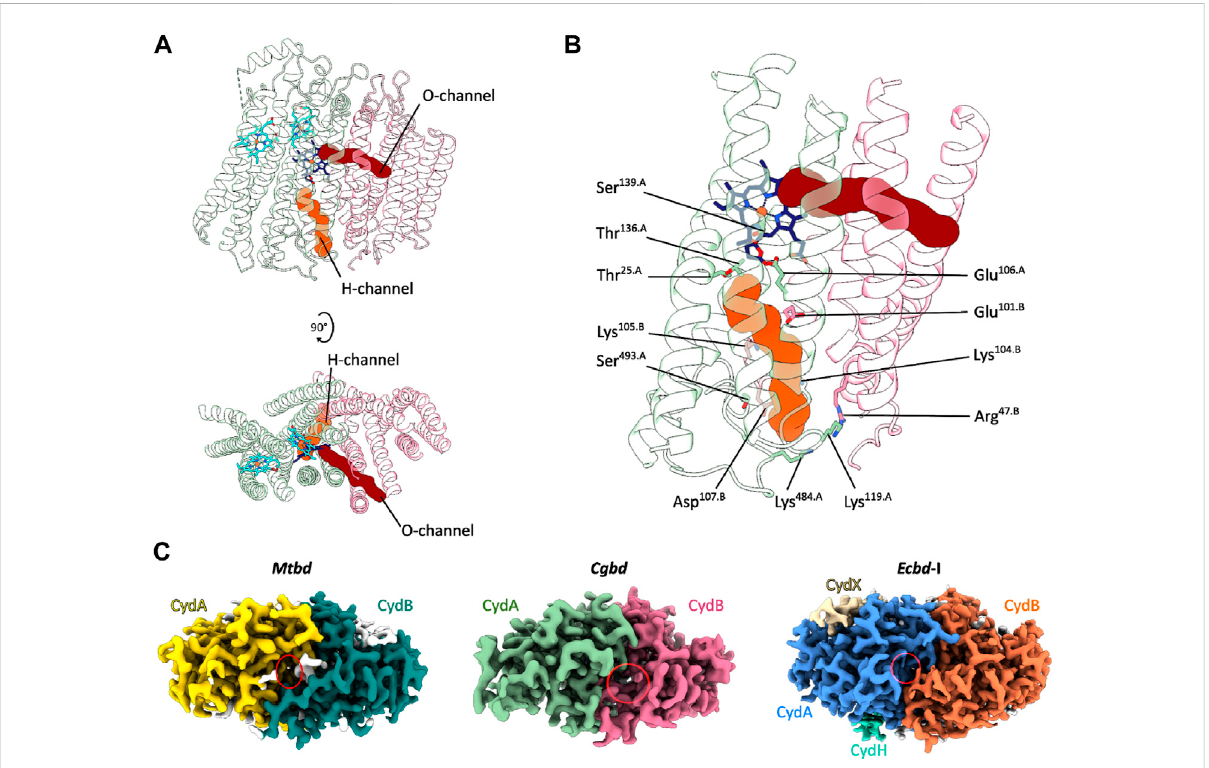
FIGURE 3 Oxygen and proton pathways in Cgbd . (A) Oxygen (O) and proton (H) channels predicted by MOLE2. The O-channel starts at the membrane interface between TMHs one,nine andtwoofCydB andTMHthree ofCydAandcontinues towardsheme d . ThepredictedH-channel allowsproton transfer from the cytoplasm to the reduction site. (B) Hydrophilic residues lining the H-channel. (C) Variation in location and size of the cytoplasmic proton channel entry sites in cytochromes bd . Depicted are the cryoEM maps of Mtbd (EMD-12451) (Safarian et al., 2021), Cgbd and Ecbd -I (EMD-4908) (Safarian et al., 2019) viewed from the cytoplasmic side of the membrane. The cavity elongating into the H-channel is highlighted by a red